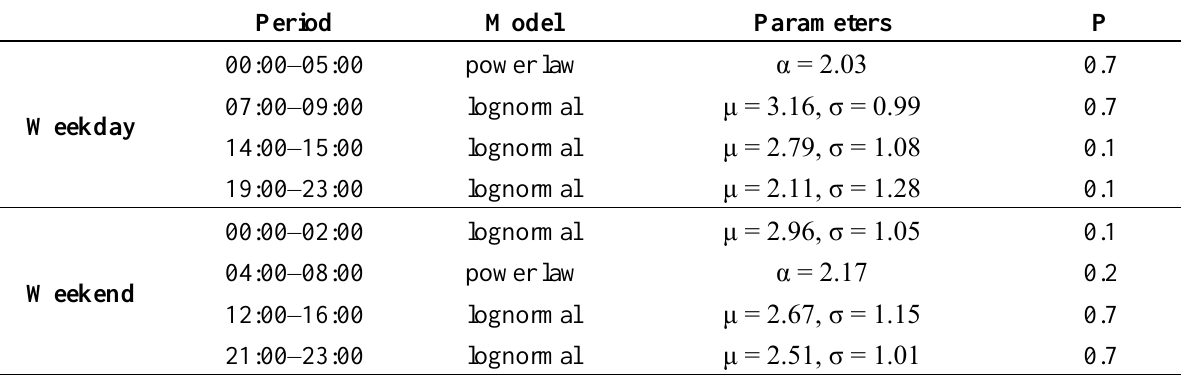
Table 1. Heavy-tailed distribution of human activities on an hourly basis.